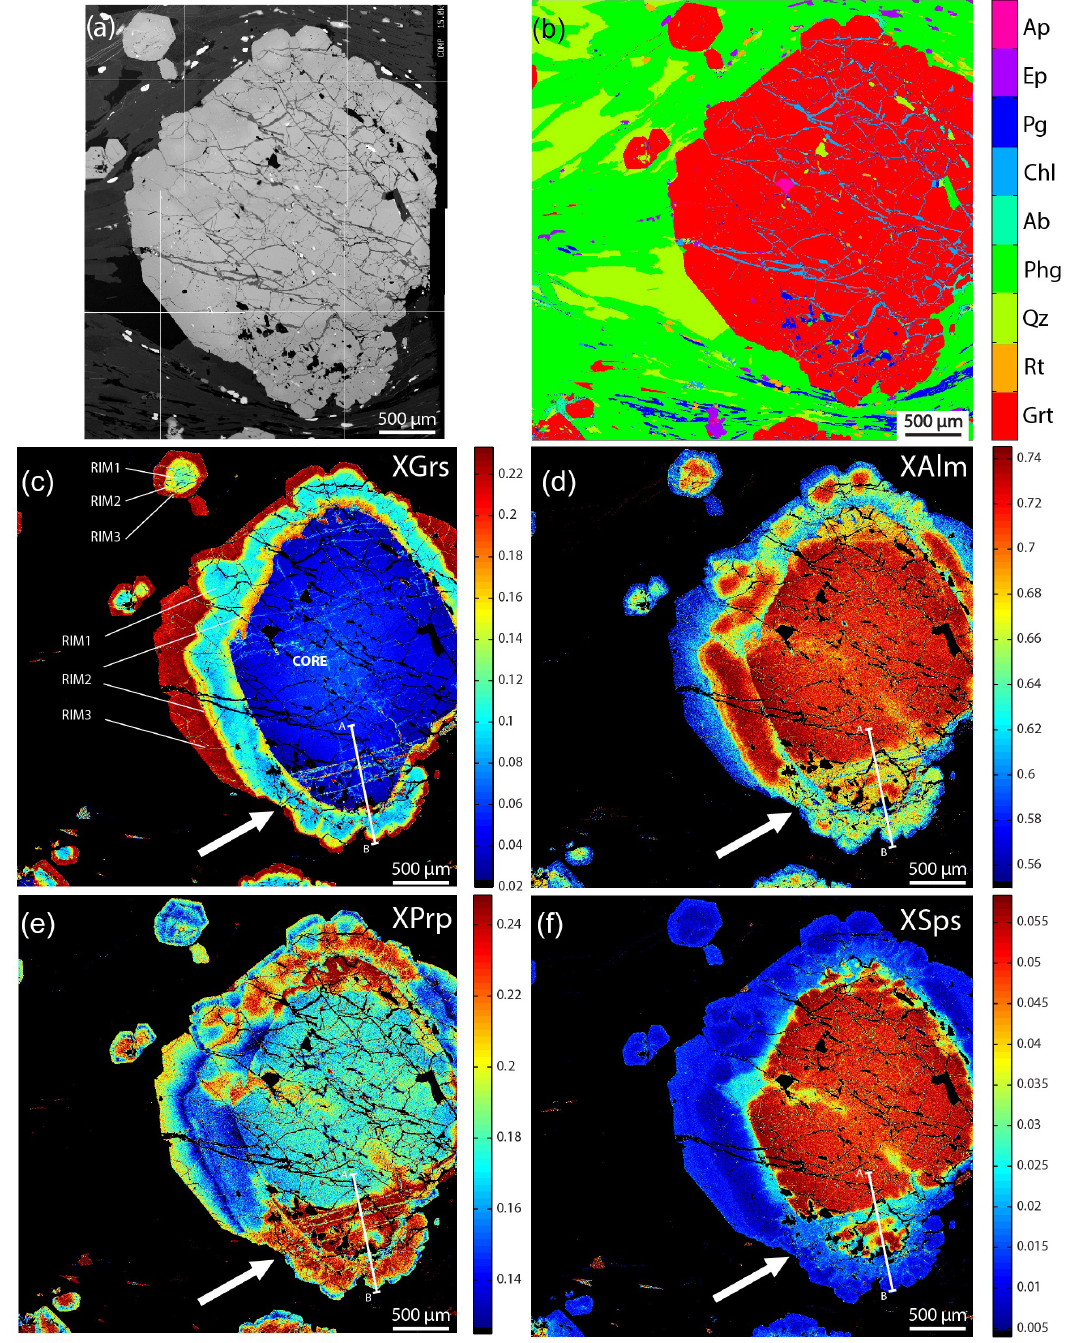
Figure 7. Large garnet (ø ∼ 3mm) in sample FG1249. (a) BSE picture shows bright porphyroclastic core and darker rim. (b) Mineral phases (based on X-ray maps). Quartz is included inside the core and at the core–rim boundary; paragonite inclusions are abundant in correspondence of the major fractures sealed by higher grossular garnet. Late fractures that dissect all the garnet are filled by chlorite and albite. (c) X Grs map. Major fractures are sealed by higher grossular garnet. Smaller garnet grains have no core but rims showing the same zoning. (d–f) X Alm , X Prp , and X Sps maps suggest incipient re-equilibration in both core and Rim1 near major fractures (arrows) and along the core–Rim1 boundary (see text for discussion). Relics of the pristine core are preserved as islands inside re-equilibrated garnet Rim2 and 3 (bottom part of figure). Note location of AB profile shown in Fig.